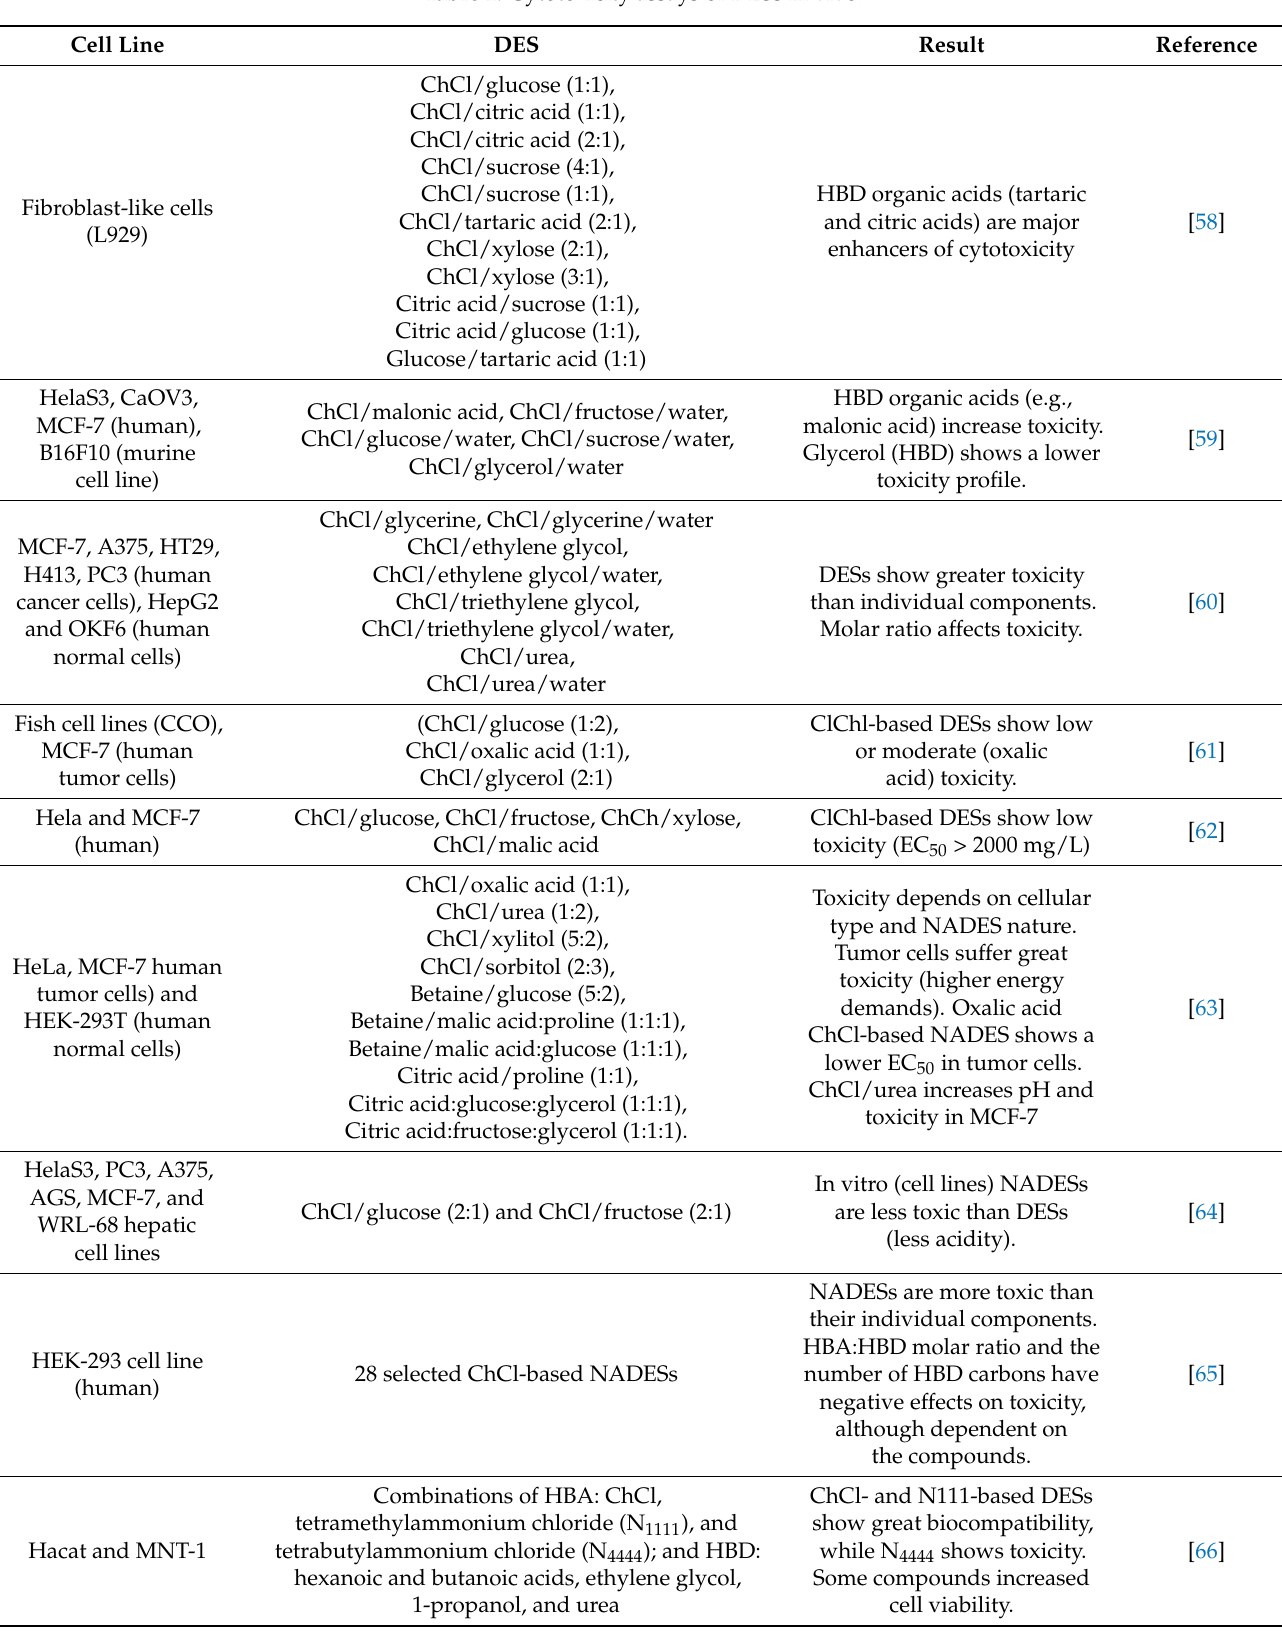
Table 1. Cytotoxicity assays of DESs in